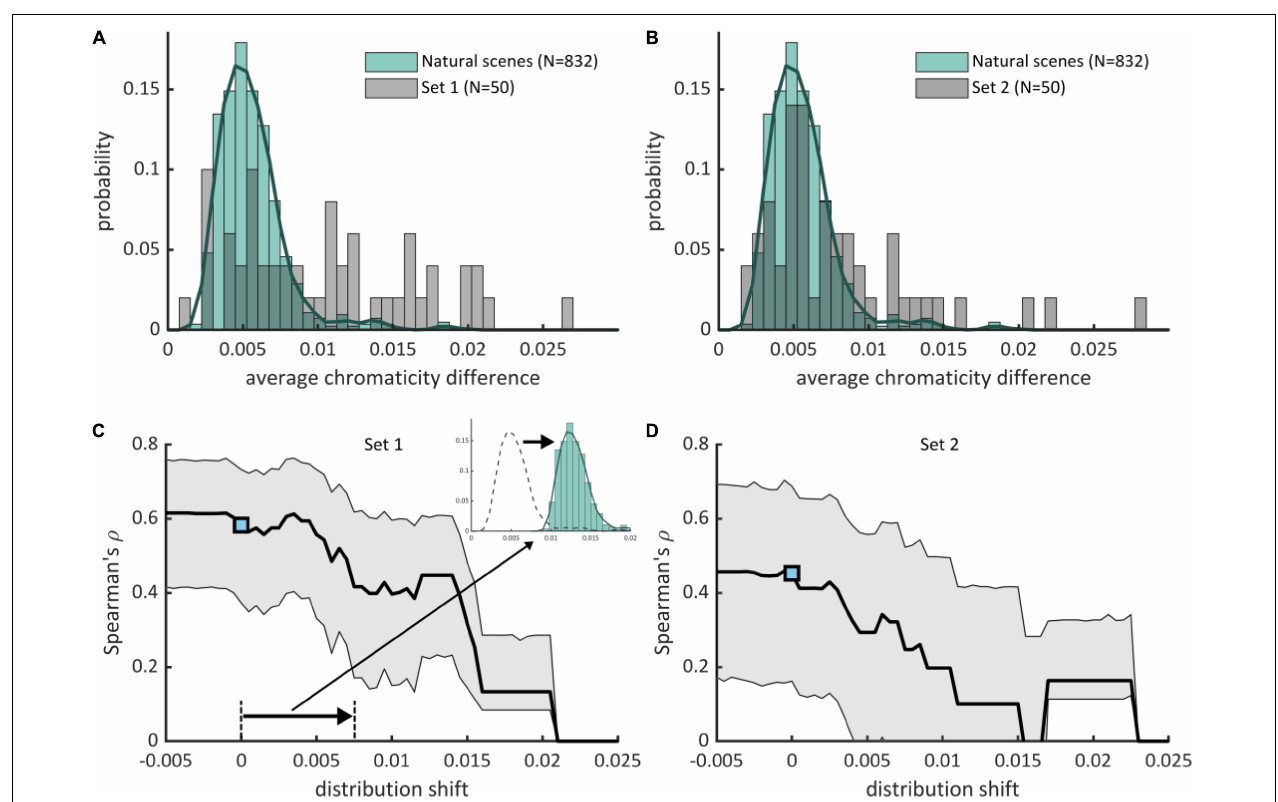
FIGURE 3 | Positive deviation of average chromaticity difference with respect to natural scenes drives visual discomfort. (A,B) (pale green boxes) Histograms and (green curve) estimated distributions of average chromaticity difference in natural scenes ( N = 832) with superimposed distribution of average chromaticity difference for the stimuli used in (A) Experiment 1 (Set 1, 50 stimuli) and (B) Experiment 2 (Set 2, 50 stimuli). Part of the stimuli have a high average chromaticity difference with respect to typical natural scenes. (C,D) (black curve) Spearman’s ρ correlations between reported visual discomfort and the rectified z-scores of the average chromaticity difference with respect to the distribution for natural scenes when the distribution is shifted toward lower or higher values of chromaticity differences for (C) Set 1 and (D) Set 2. The reference distribution for natural scenes corresponds to shift = 0, with the associated correlation shown by a blue point [ (C) , Experiment 1, 0.62, ci = (0.42, 0.76); (D) , Experiment 2, 0.43, ci = (0.15, 0.67)]. Gray-shaded intervals correspond to 95% confidence intervals for Spearman’s ρ correlations. Correlations decrease when the distribution for natural scenes is shifted toward positive values, showing that positive deviation of average chromaticity difference with respect to the reference distribution for natural scenes (shift = 0) is the best predictor of visual